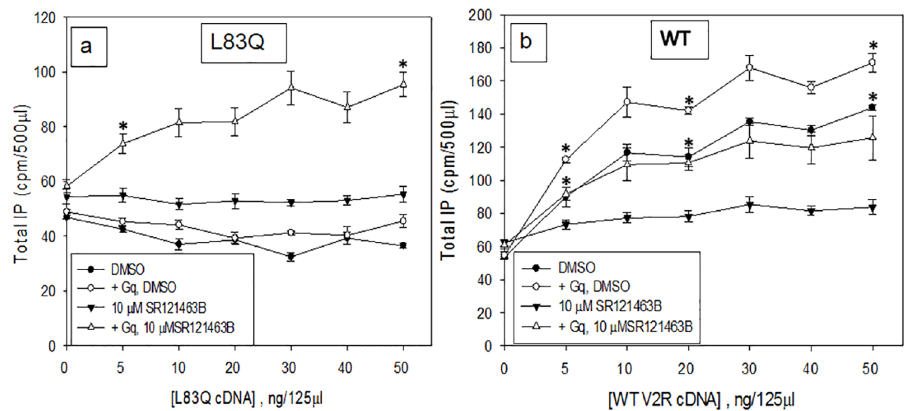
Fig 5. IP production by HeLa cells, with or without cDNA for Gq, with or without rescue by pharmacoperone SR121463B. HeLa cells were transiently co-transfected with L83Q mutant + 10ng Gq (a) or hWT V2R + 10ng Gq (b) to assess IP responsewith with or without rescue. Cells were either treated with SR121463B or not (in which case an equivalent amount of DMSO was present). Cells were